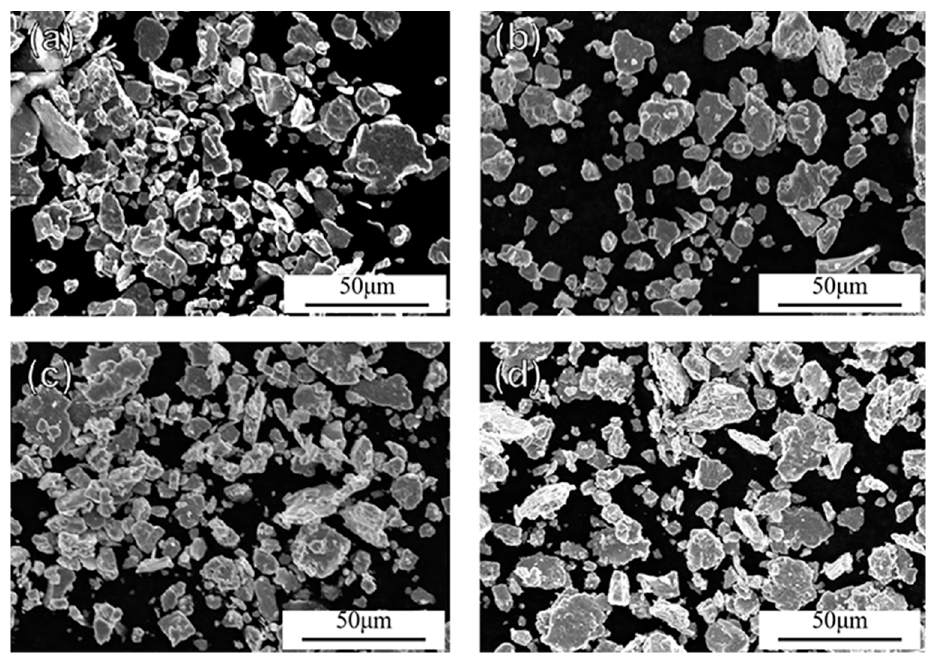
Figure 3. SEM images of Fe 73.2 Si 16.2 B 6.6 Nb 3 Cu 1 nanocrystalline alloy powder after milling for ( a ) 6 h, ( b ) 8 h, ( c ) 10 h, and ( d ) 12 h.